Question: Provide a one-line summary of what is displayed.
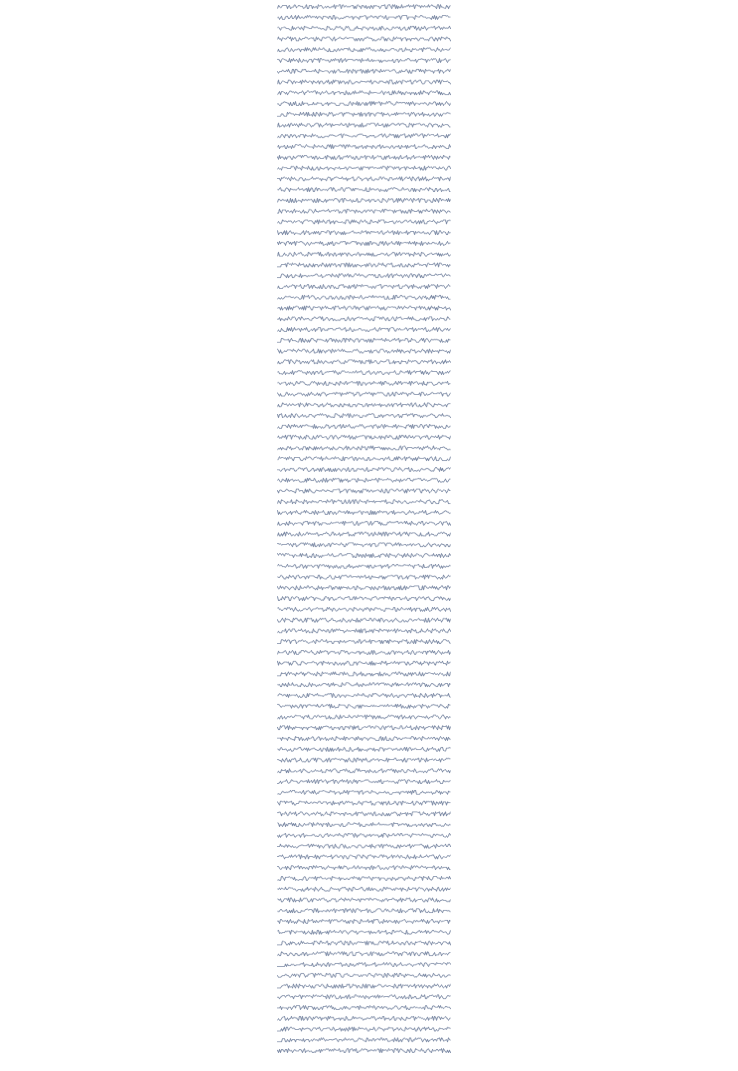
Answer: 100 trendlines for all NIST tests p-values after applying between 0 and 99 coning operations on a vector of length 3751, with a pattern of all 1’s